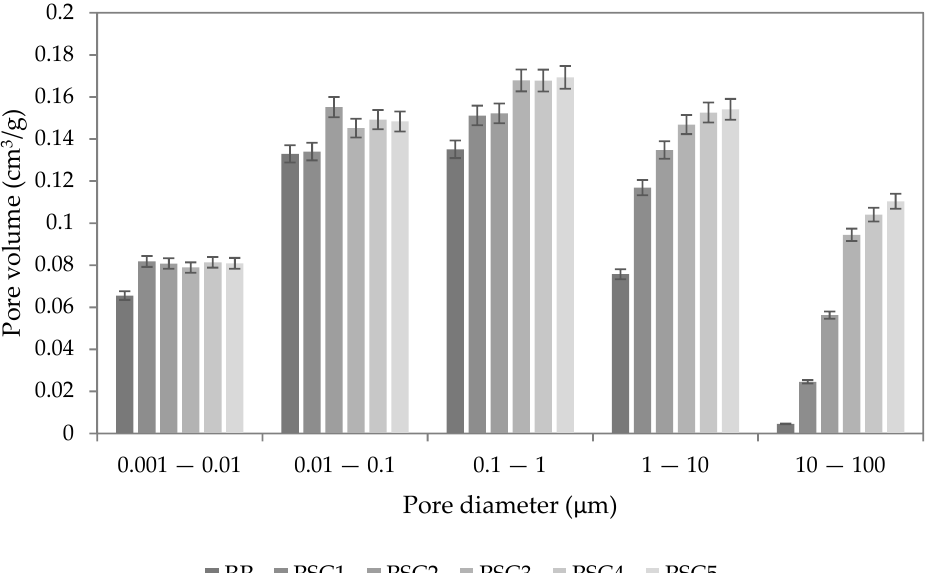
Figure 3. Pore size distribution of studied plasters.